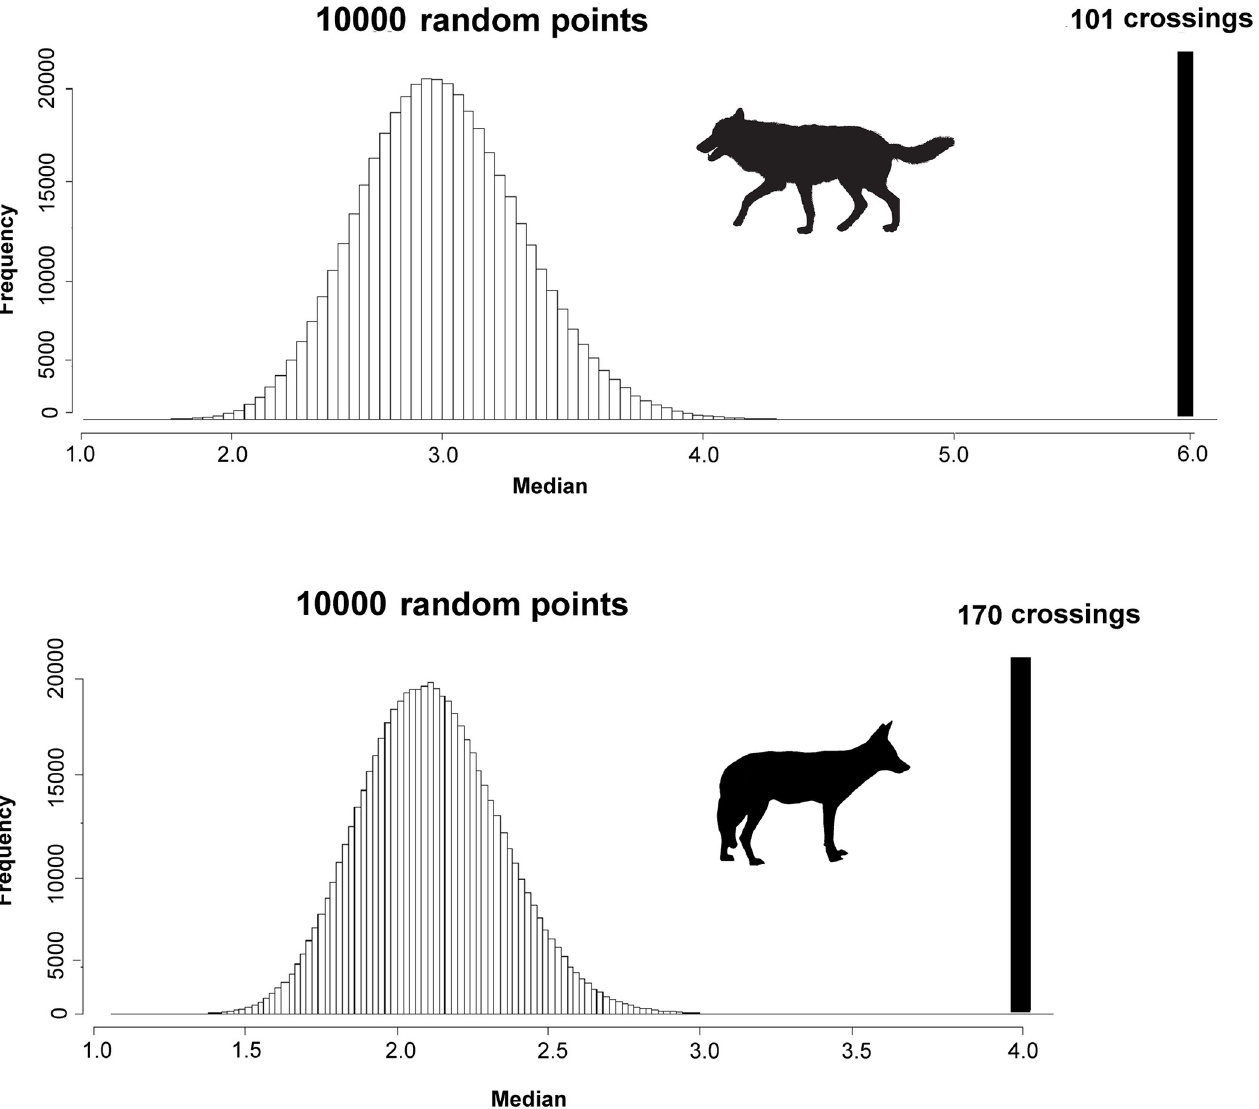
Fig 6. Spatial randomization test: The crossing location of grey wolf (above) and golden jackal (below) has a much higher connectivity score than the randomization. A solid vertical line shows the median of 101and 170 crossing locations for grey wolf and golden jackal respectively. Transparent bars show the distribution of the median connectivity values of 10000 random spatial samples across the road